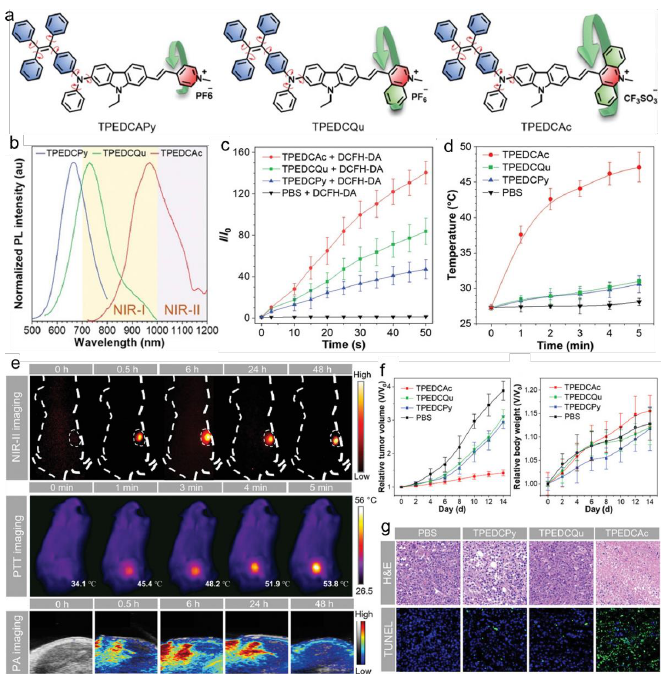
Figure 4. ( a ) Chemical structures of TPEDCPy, TPEDCQu, and TPEDCAc. ( b ) PL spectra, ( c ) ROS generation using DCFH-DA, and ( d ) photothermal curves of different AIE aggregates under 660 nm laser irradiation ( n = 3). ( e ) In vivo NIR-II fluorescence, photothermal, and PA imaging of MCF-7 tumor-bearing mice. ( f ) Relative tumor volume and body weight of MCF-7 tumor-bearing mice after different treatments ( n = 5). ( g ) Hematoxylin and eosin (H&E) and TdT-mediated dUTP-biotin nick end labeling (TUNEL) staining analyses of the tumor tissues receiving different treatments (Reprinted with permission from Ref. [94]. Copyright 2022, Wiley-VCH GmbH).